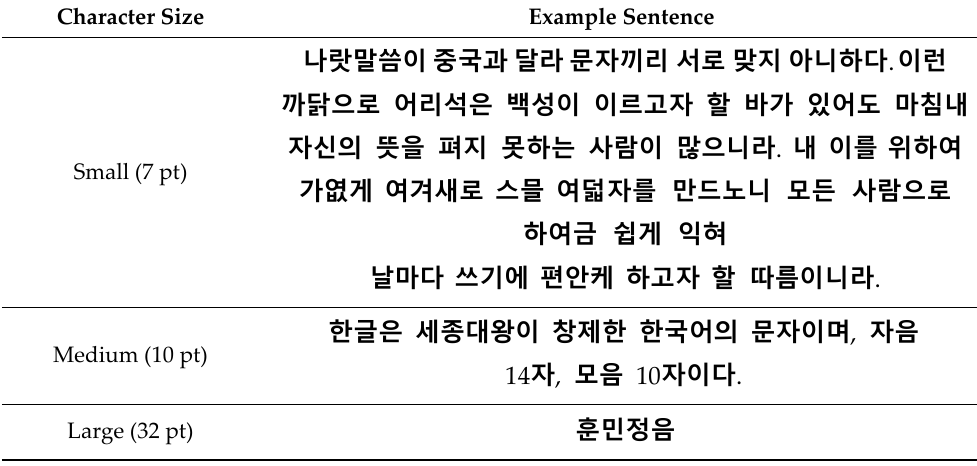
Table 6. User Survey Examples.